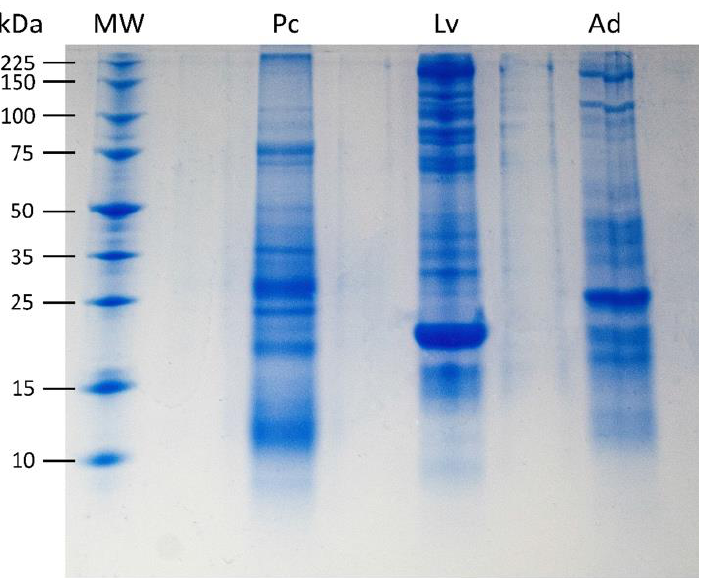
Figure 2. Tricine-SDS-PAGE of 5 μg foam nest fluid from P. cuvieri (Pc), L. vastus (Lv), and A. hylaedactyla (Ad). Molecular weight (MW) range of 10 to 225 kDa. The most intense band in Lv, of 23.5 kDa, corresponds to Lv-ranaspumin as described in Hissa et al., 2014 [35].